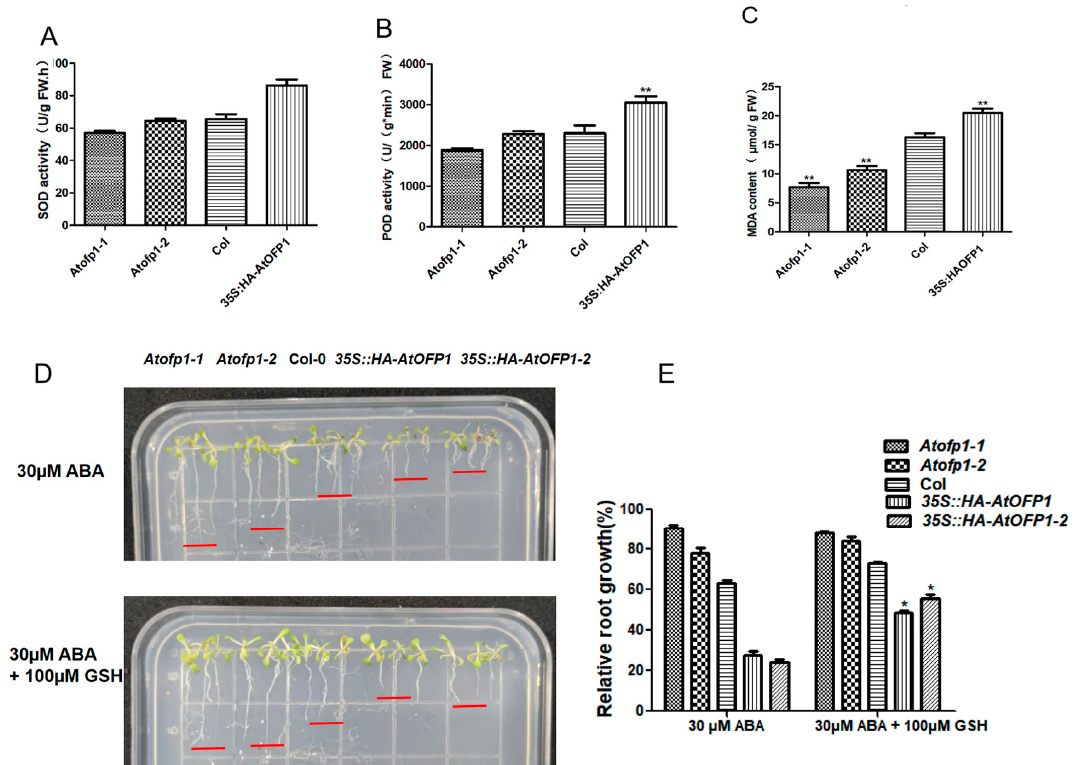
Figure 7. Comparison of antioxidant enzyme activities (SOD and POD) and Malondialdehyde (MDA) in the Col-0, Atofp1-1 , Atofp1-2 , and 35S::HAOFP1 OE lines. ( A ) The enzyme activities of SOD. ( B ) The enzyme activities of POD. ( C ) The contents of MDA. ( D ) Root elongation of Col-0 , Atofp1-1 , Atofp1-2 , 35S::HA-AtOFP1 , and 35S::HA-AtOFP1-2 after 7 days on 30 µ M ABA (top panel) and 100 µ m GSH containing 30 µ M ABA (bottom panel). ( E ) Statistical analysis of root growth in ( D ). Data shown are mean ± SD of three replicates. Asterisk (*) indicates statistically different from Col wild-type ( p < 0.05), while ** represents significantly statistical difference ( p < 0.01).